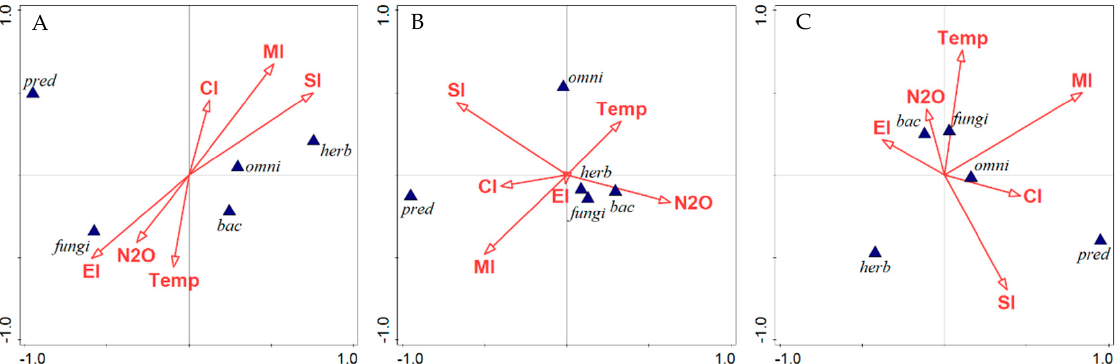
Figure 2. A canonical correspondence analysis biplot of environmental variables (red arrows) with nematode abundance variables (triangles) in ( A ) 2012 eggplant, ( B ) 2013 corn and ( C ) 2014 eggplant cropping systems following four soil treatments. Bac = bacterivores, Fungi = fungivores, Herb = herbivores, Omni = omnivores, Pred = predators; CI = channel index, EI = enrichment index, MI = maturity index, SI = structure index, Temp = soil temperature, and N 2 O = N 2 O emissions corresponding to nematode sampling time.